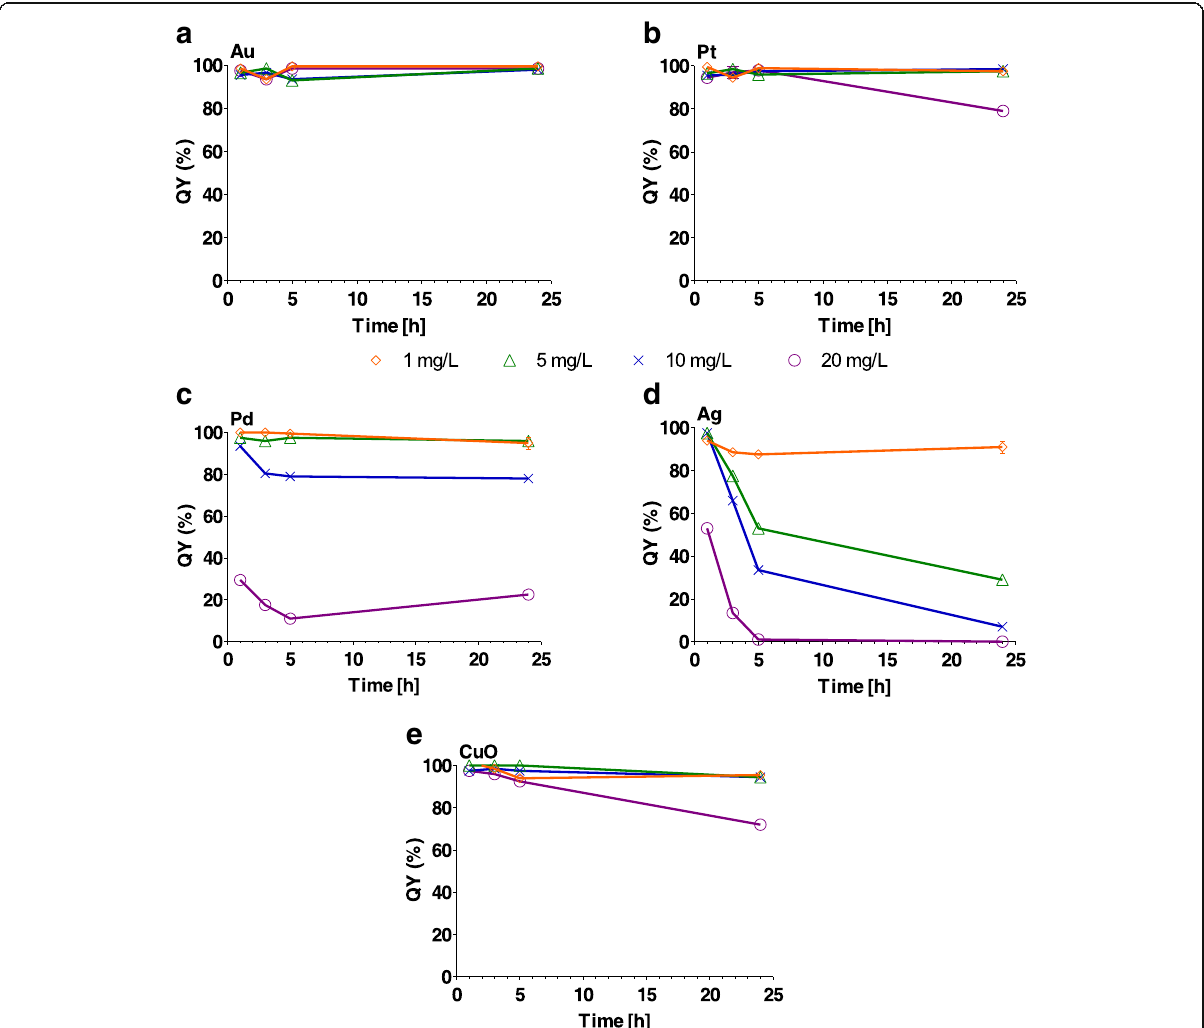
Fig. 6 Effect of a Au, b Pt, c Pd, d Ag and e CuO nanoparticles (1, 5, 10 and 20 mg/L) on photosystem II efficiency (QY %) after 1, 3, 5 and 24 h. One hundred percent on the y -axis represents the QY of the control algal culture without nanoparticles. The error bars represent the standard deviation of repeated experiments of duplicated